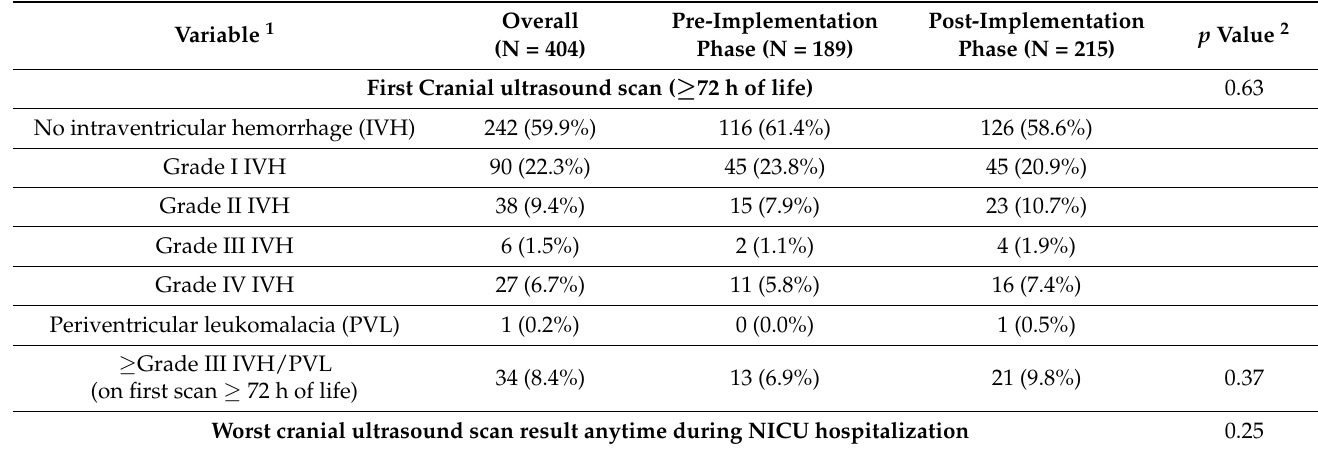
Table 3. Short-term neonatal